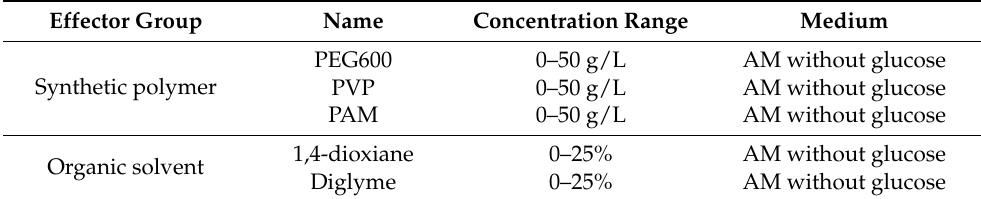
Table 2. Effectors and range of concentrations used in the screening experiments.